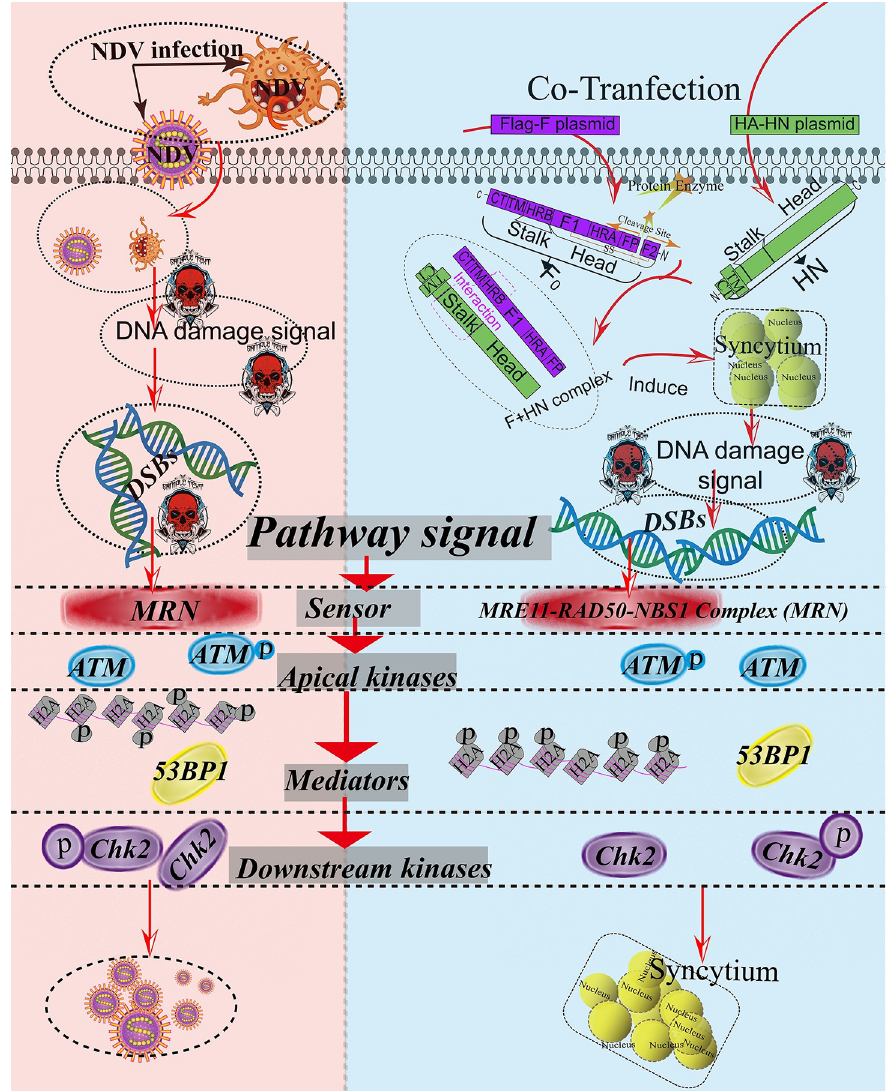
Fig 8. Schematic of the ATM-mediated DNA double-strand breaks (DSBs) triggered by virulent NDV infection and membrane fusion. Virulent oncolytic NDV infects target tumor cells through viral HN-mediated attachment. It then triggers F protein conformational changes and releases fusion peptides to fuse the viral and cellular membranes [29, 30]. Meanwhile, after transfection, the inactive precursor of F protein (F 0 ) is proteolytically cleaved by the host-cell protease at the cleavage site and forms a biologically active protein comprising the disulfide-linked F 1 +F 2 heterodimer [29–31]. After a series of proteolytic processing and conformational changes, the fusogenically active F 1 protein and HN form an F+HN complex via the interaction between a stalk and an HRB domain [29, 30]. Once triggered, HRB completely refolds around HRA, thereby forming stable 6 HB and a fusion pore [30] and consequently inducing membrane fusion and syncytium formation. The virulent oncolytic NDV infection and F-HN co-expression induce DSBs in tumor cells, leading to the recruitment of the MRN complex and the separation of the dimeric, inactive form of ATM into a monomeric, phosphorylated form, which is further activated by the MRN complex through directly binding ATM at DSB sites [10]. ATM activation by DSBs occurs in two steps [2, 14]. Activated ATM initially triggers a rapid cascade of phosphorylation events involving H2AX, 53BP1, and Chk2. Mediators and signal transducers are then recruited to amplify the signal, which finally reaches effector proteins that trigger the cellular response to DNA damage [1, 6, 18]. Eventually, ATM-mediated DSBs facilitate oncolytic NDV replication and promote syncytium formation. The solid arrows indicate the stimulation and protein requirements for accumulation.